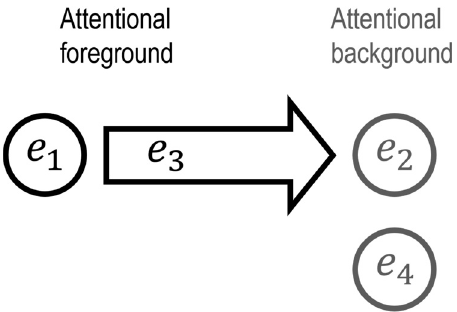
Figure 4: If the di ff erence between items that are attended to and items that are not attended to consists in the fact that items outside the focus of attention are represented as being determinable, then e 3 can connect e 1 and e 2 , without requiring that both be attended to, i.e., without requiring that both be determinate